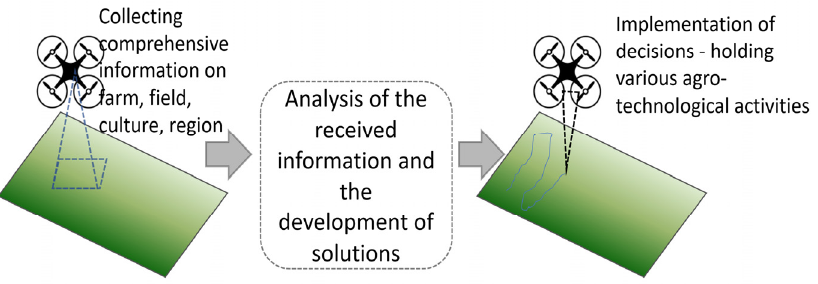
Figure 2. IUAVT as a component of precision agriculture. Source: Generated by the authors.